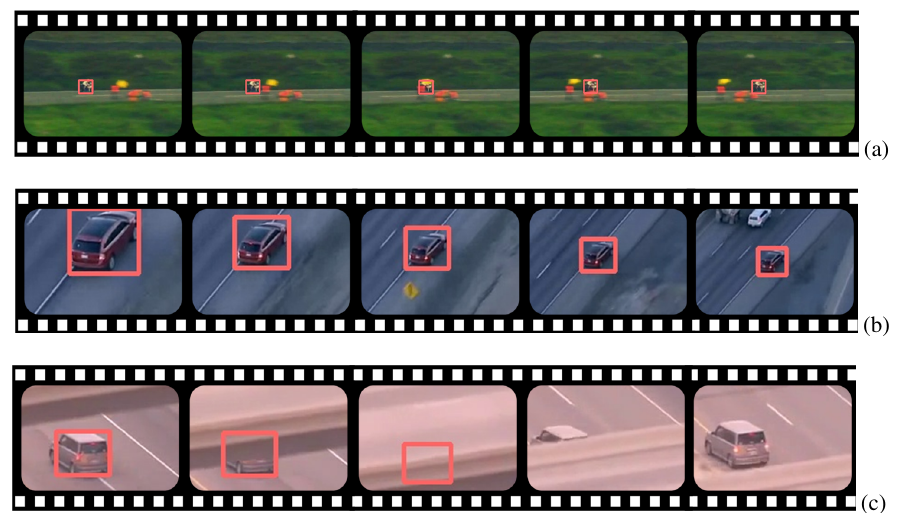
Figure 3. Indication of the tracking results of GOTURN on example aerial image sequences acquired by web search. (a) Successful tracking with small object and the presence of occlusion. (b) Tracking the object in the presence of scale change between the frames. (c) Example of a failure case when the object is occluded for a longer